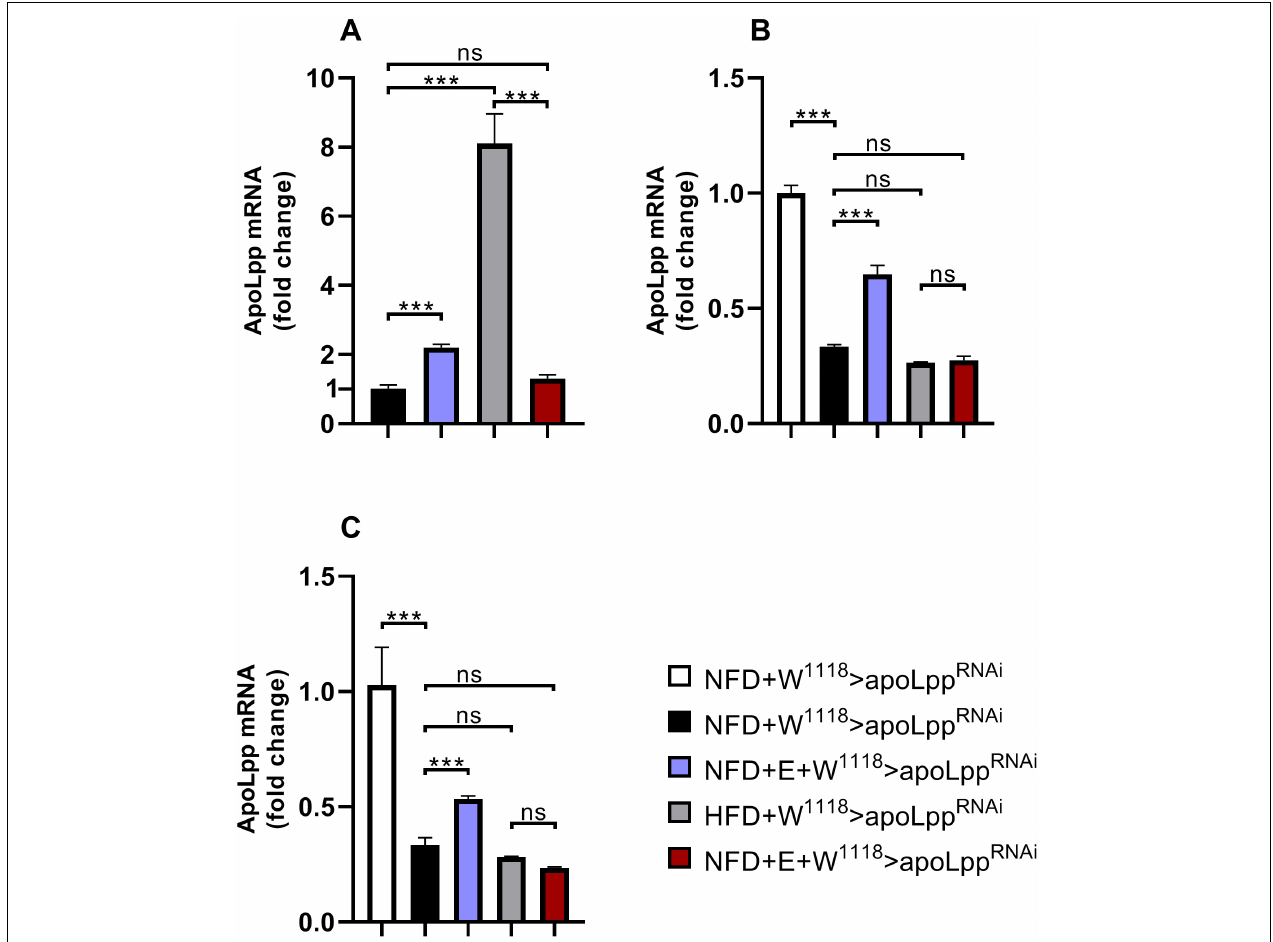
FIGURE 5 | Drosophila heart and whole-body apoLpp mRNA relative expression level. (A) W 1118 group flies heart apoLpp expression level. (B) Arm group flies heart apoLpp expression level. (C) Hand group flies heart apoLpp expression level. All flies were females, and the sample size of each group was 60 hearts or 10 whole-body. GAPDH was used to normalize the values. Independent sample t -test was used to identify differences between W 1118 > apoLpp RNAi flies and Arm-Gal4 > apoLpp RNAi or Hand-Gal4 > apoLpp RNAi flies. A two-way ANOVA was used to identify differences among the NFD, NFD + E, HFD, and HFD + E groups in Arm-Gal4 > apoLpp RNAi or Hand-Gal4 > apoLpp RNAi flies. * P < 0.05, ** P < 0.01, *** P <